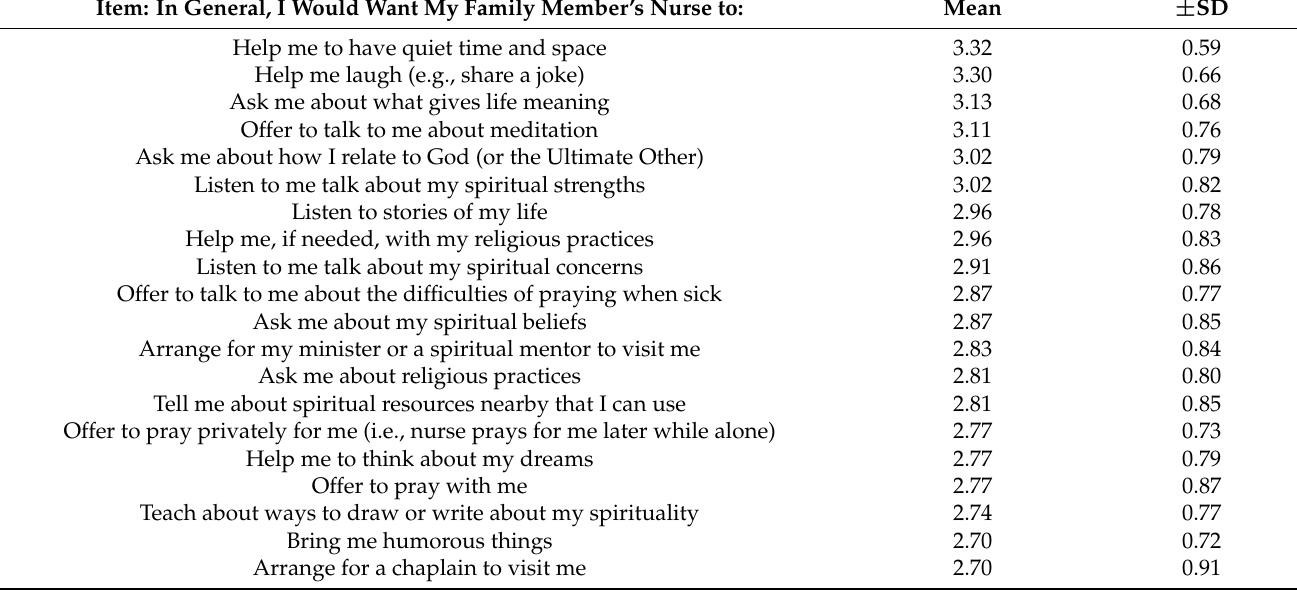
Table 3. Mean NSTS scores on preferred spiritual practices ( n =